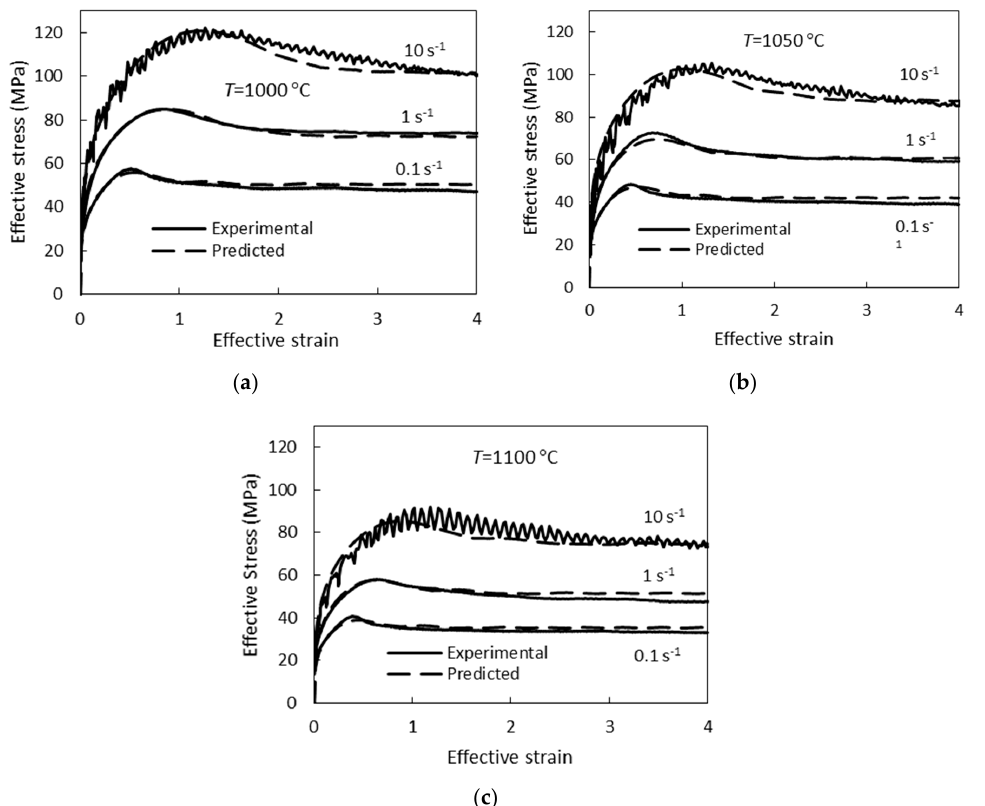
Figure 4. Comparison between the experimental and predicted flow curves determined at ( a ) 1000 ° С , ( b ) 1050 ◦ C, and ( c ) 1100 ◦ ( b ) 1050 ° С , and ( c ) 1100 ° С .